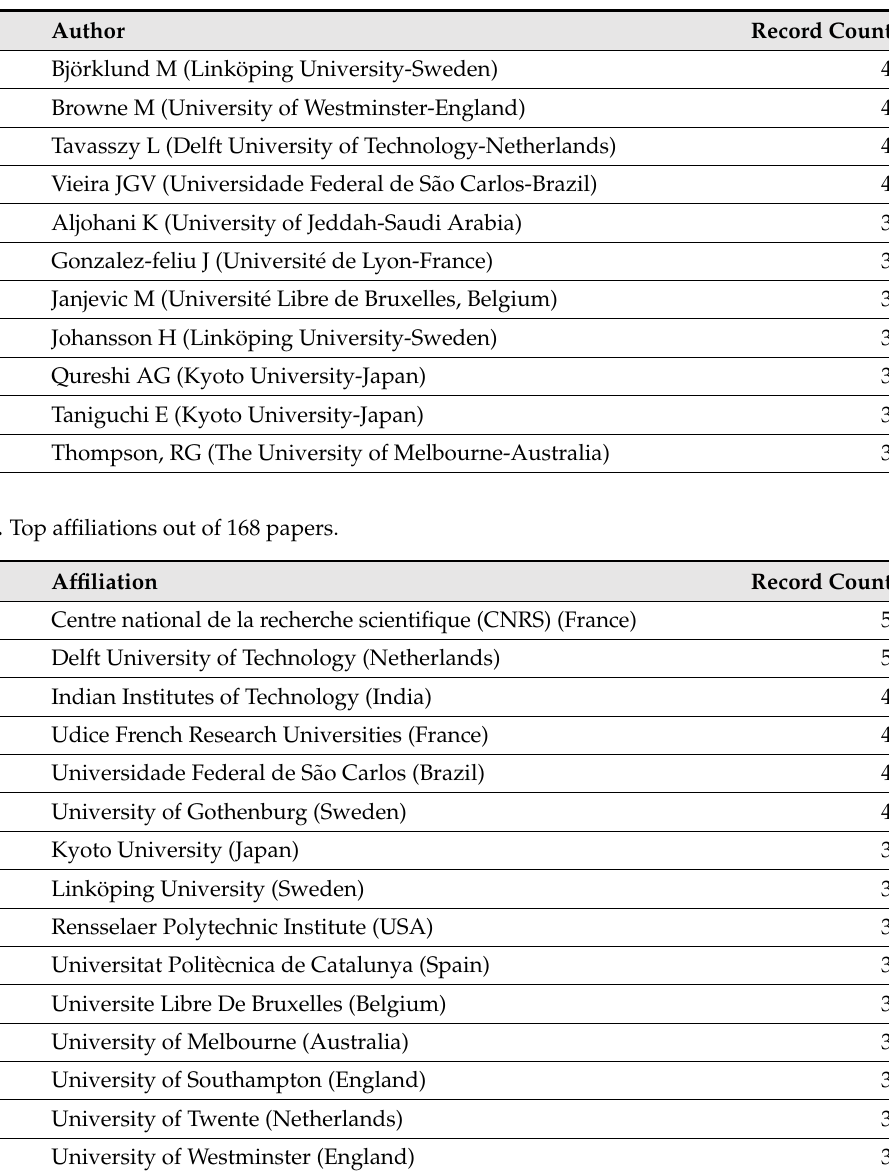
Table 2. Top-publishing authors out of 298 papers.